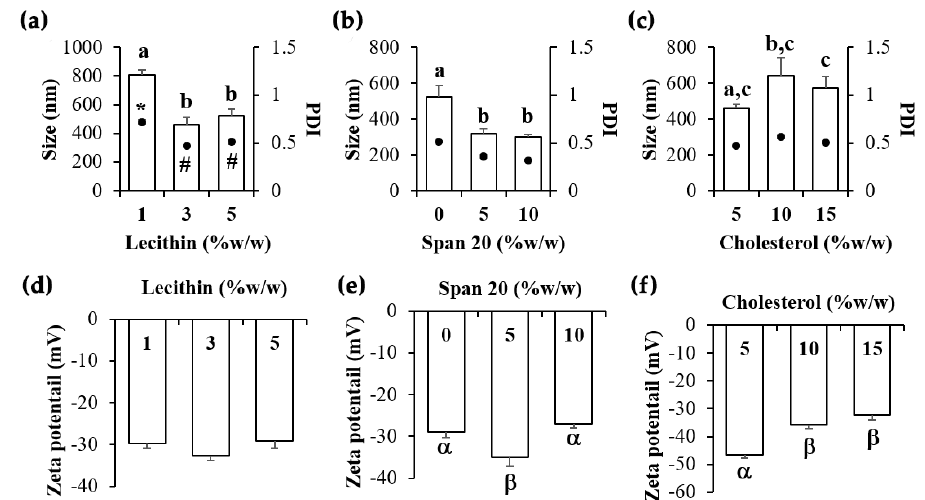
Figure 3. Particle size and polydispersity index (PDI) of liposome and niosome were developed using ( a ) various amount of lecithin, ( b ) Span 20 ® , and ( c ) cholesterol. Zeta potential of liposome and niosome were developed using ( d ) various amount of lecithin, ( e ) Span 20 ® , and ( f ) cholesterol. The letters, a, b, and c denote values that were significantly different in particle size ( p < 0.05), whereas the symbols * and # denote values that were significantly different in PDI ( p < 0.05). The symbols α and β denote significantly different values in zeta potential ( p < 0.05).